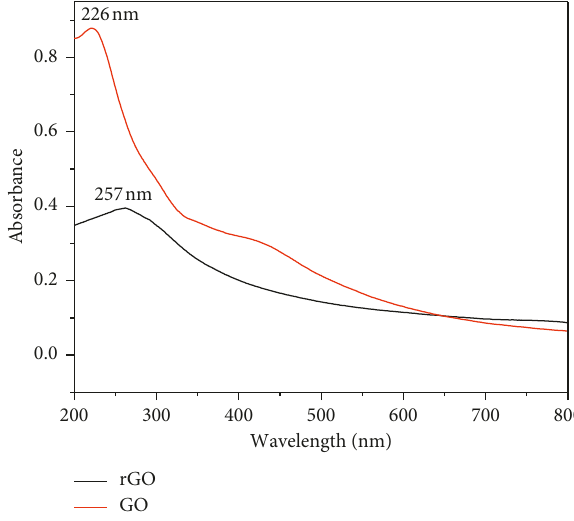
Figure 4: UV-Vis spectra of GO and rGO.